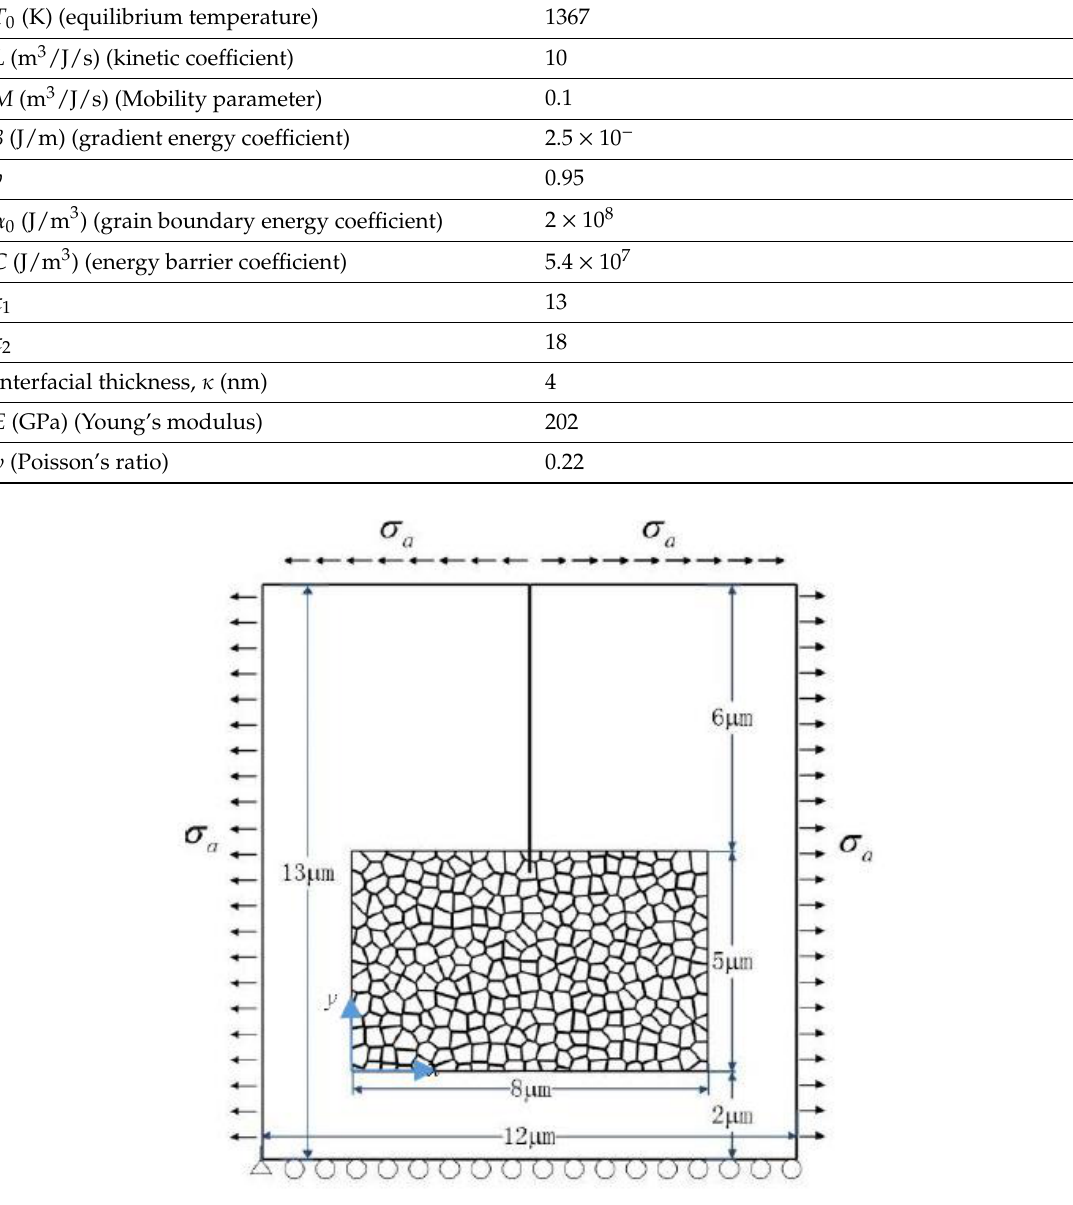
Table 2. Material properties and the other parameters in the phase field (PF) simulation.